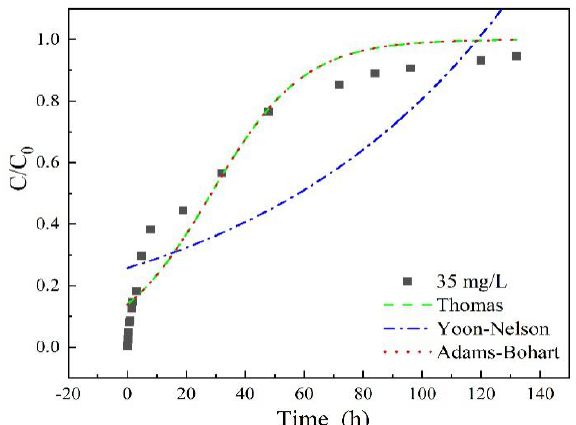
Figure 7. Adsorption breakthrough curves fitted by different models with sulfamethoxazole initial concentration of 35 mg/L, flow rate of 3 mL/min, pH 6.5, column height of 3 cm. Table 2. The summary of experiment parameters calculated from different models under various experimental conditions.